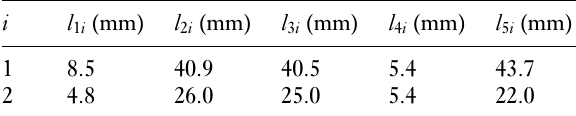
Figure 6 A simulation of the finger-driving mechanism of Table 1 and Figure 3 mimicking the human motion of Figure 4. Table 1 Sizes of the finger prototype of Figure 1 with kinematic design of Figure 3